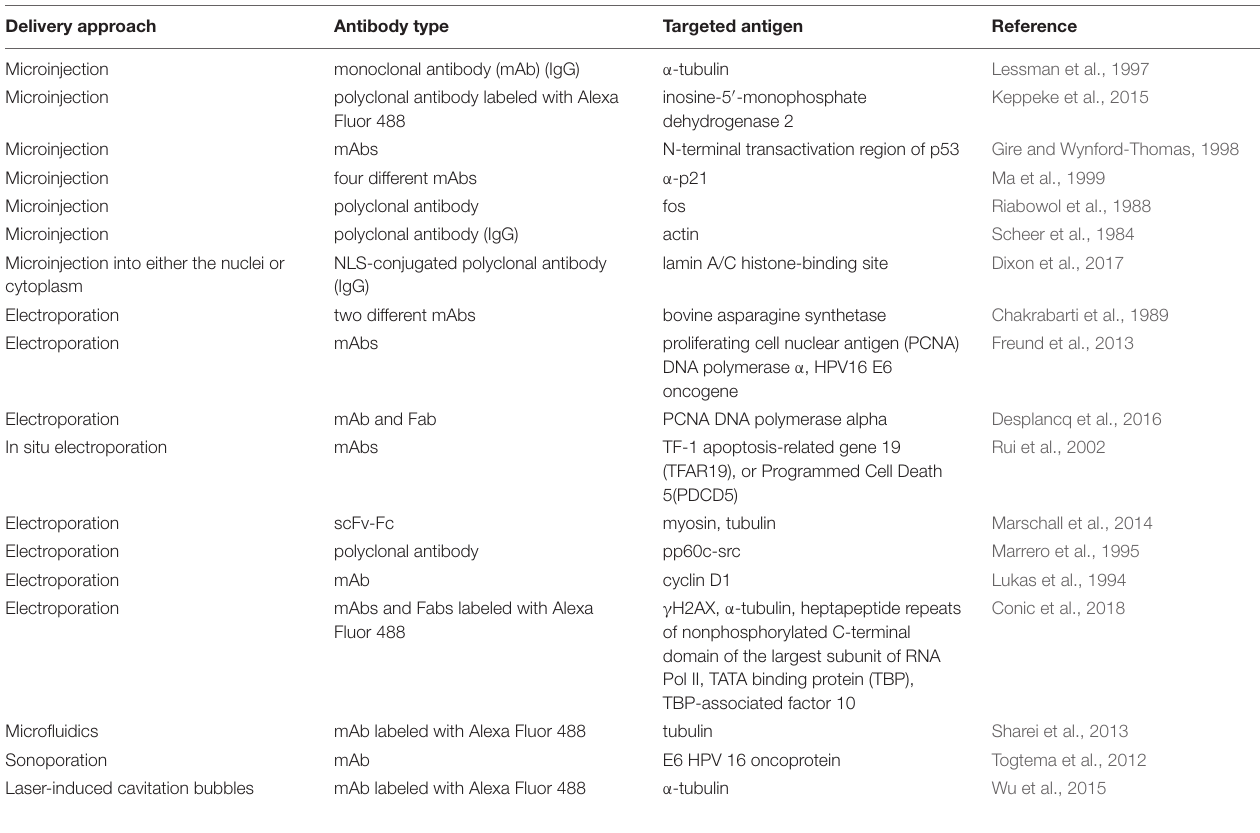
TABLE 1 | Examples of physical delivery of antibodies inside